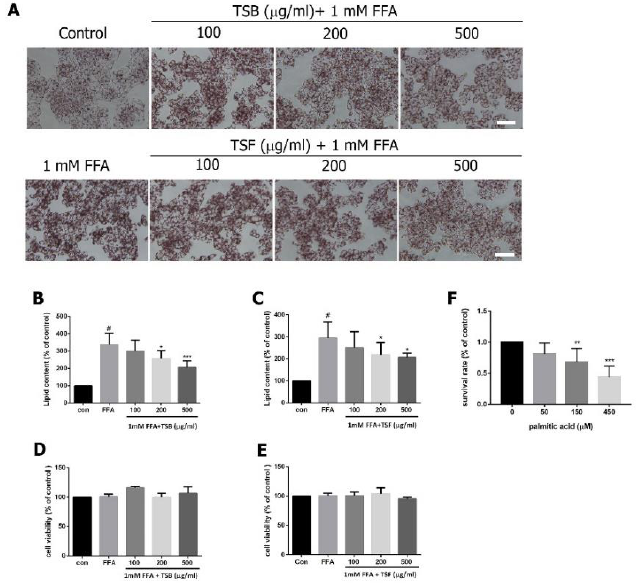
Figure 3. Effects of TSB and TSF extracts on lipid accumulation and cytotoxicity in HepG2 cells. ( A ) Oil Red O staining. Scale bar = 50 µ m. The representative images are from eight independent experiments. ( B and C ) Quantification of lipid contents. ( D – F ) MTT assays. Data were quantified for three to twelve independent experiments and expressed as mean ± SD. # P < 0.05 compared with the control group (0 g / mL)). * P < 0.05 compared with the FFA group. In B–D, *** P < 0.001. In Figure 3F, ** P < 0.01, *** P < 0.001 compared with contro (0 M).